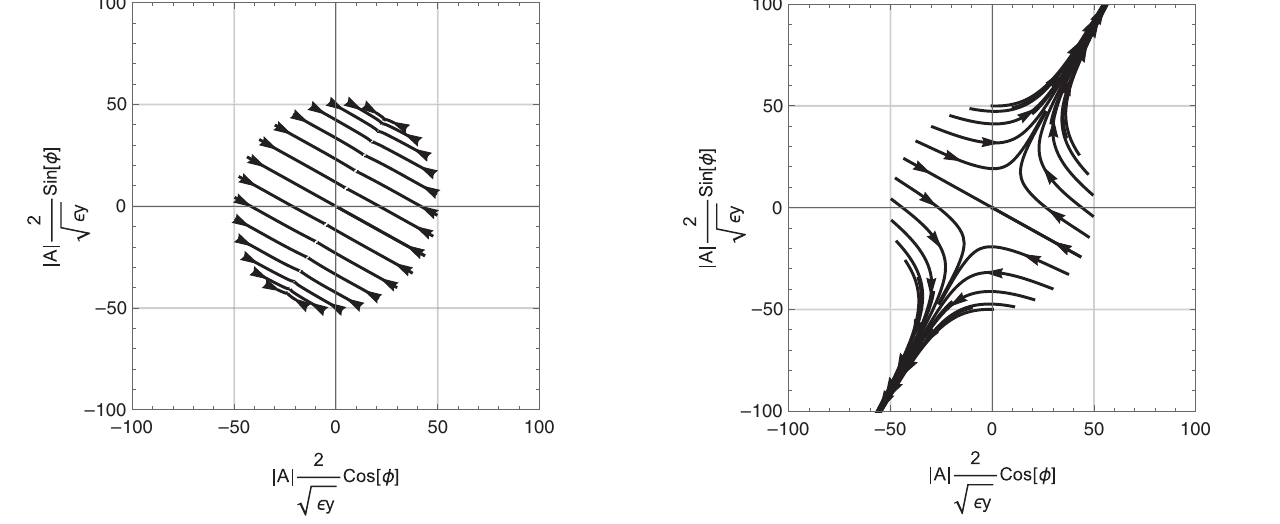
FIG. 17. Evolution of the average particle trajectories, solu- tion of Eqs. (A4) and (A5) with the same initial amplitude and different initial phases. Initial amplitude corresponds to